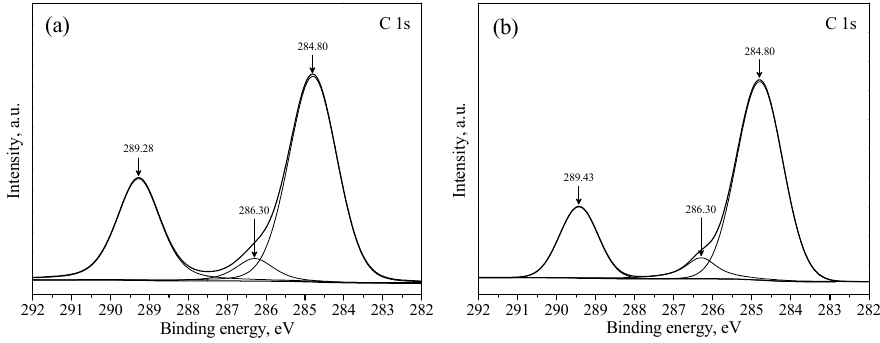
Figure 3. C 1s spectra for the mineral surface treated with chloride ions: ( a ) before; ( b ) after.